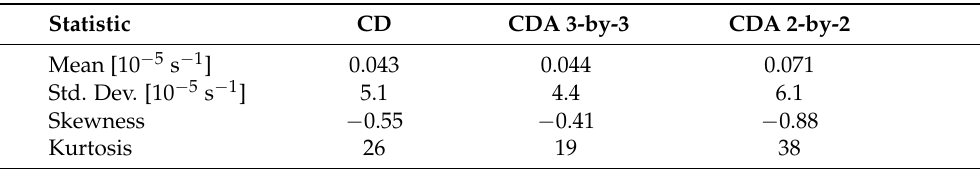
Table A1. Comparison of first four moments of probability distribution of wind divergence P ( δ ) obtained for standard central difference scheme (CD), and two central-difference-then-average (CDA) schemes: on a 3-by-3 block and a 2-by-2 block of